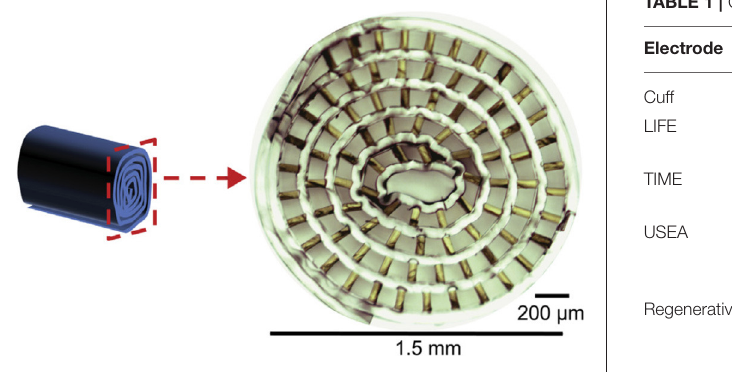
FIGURE 7 | Scaffold sieve electrode. Reproduced with permission from Srinivasan et al. (2015).